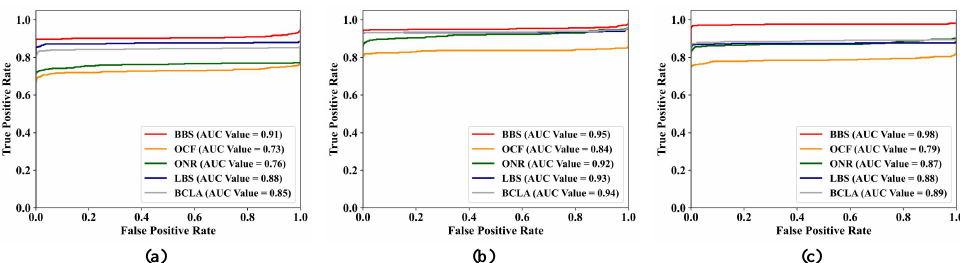
Figure 17. The ROC of ( P D , P F ) for the UTD results on the sea water data set with different band selection methods. The number of selected bands is ( a ) 17, ( b ) 27, ( c ) 42.